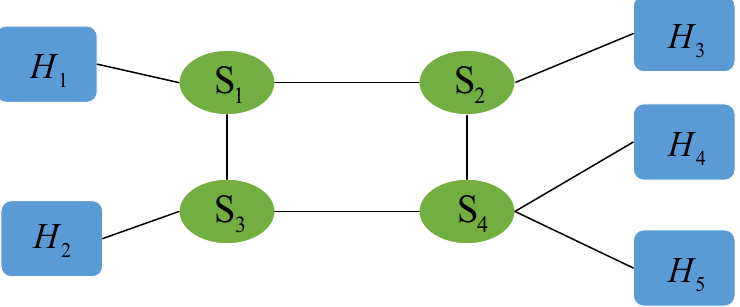
Figure 1. Example of Time-Sensitive Networking (TSN) network topology model.